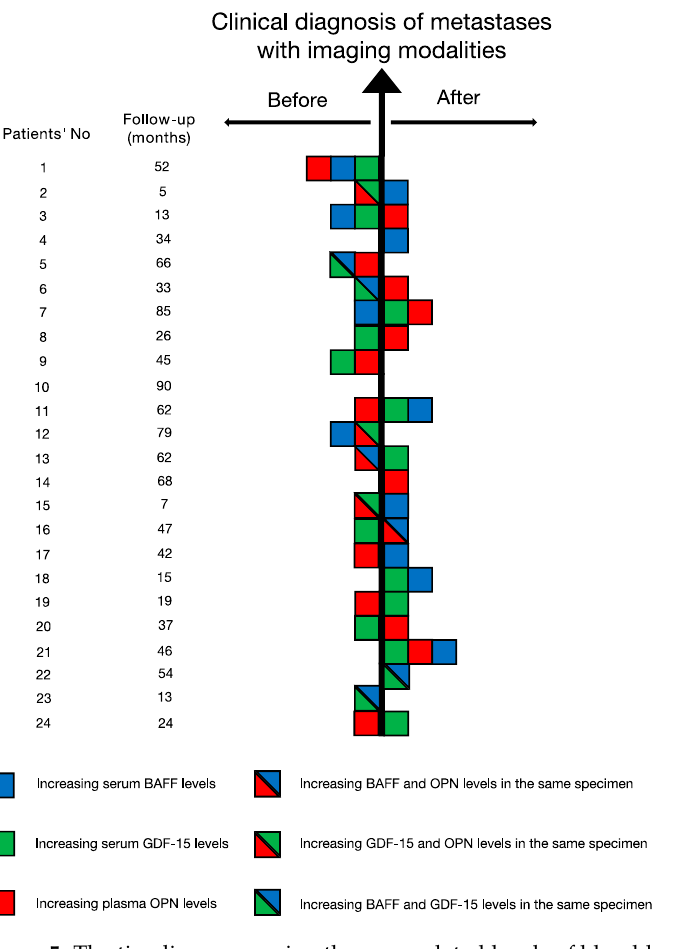
Figure 5. The timeline concerning the upregulated levels of blood-based BAFF, OPN and GDF-15 and the clinical diagnosis of metastases in 24 UM patients.